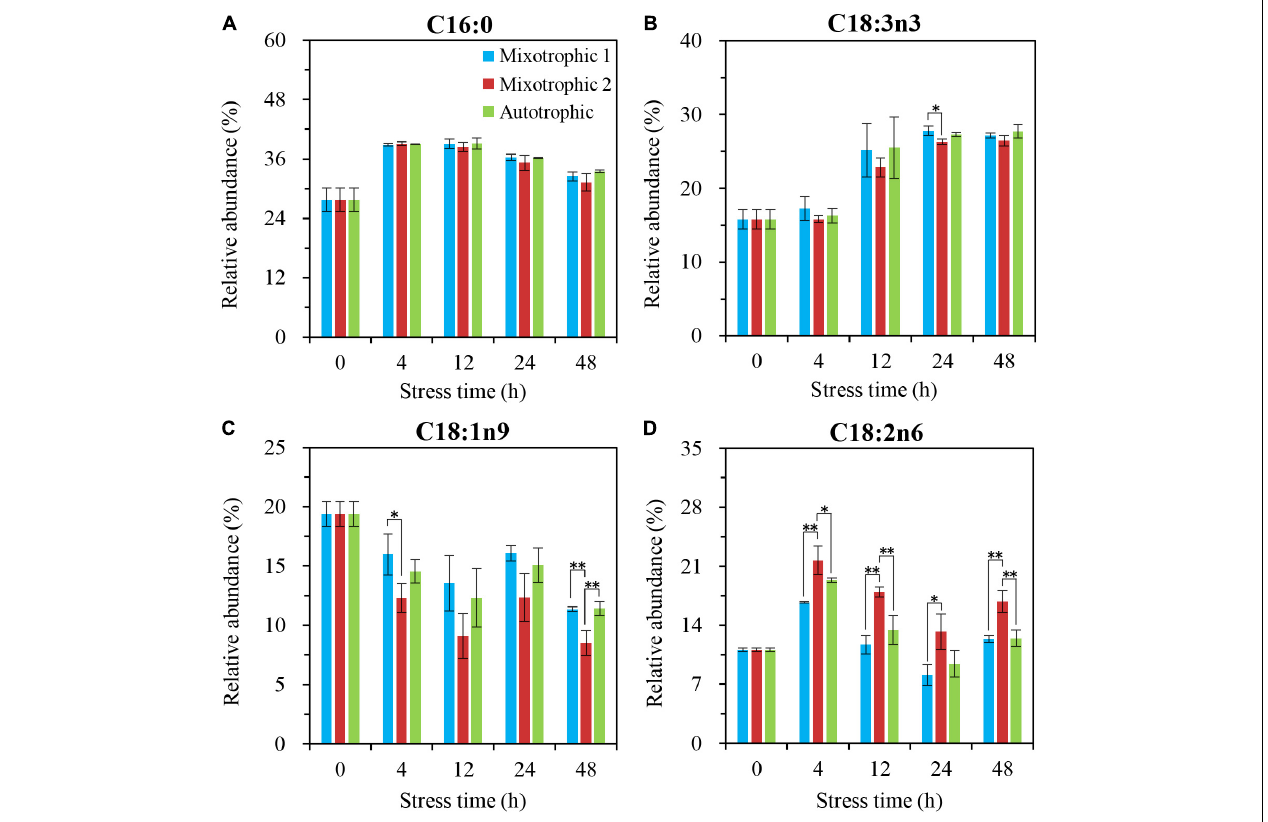
FIGURE 9 | Time course of changes in the relative abundances of the major fatty acyls in DGDG of C. reinhardtii BAFJ5 under three carbon supply regimes over 48 h of HL-N. The carbon supply regimes for mixotrophic 1, mixotrophic 2, and autotrophic were 17 mM acetate and 2% CO 2 (v/v), 17 mM acetate and ambient 0.04% CO 2 (v/v), and 2% CO 2 (v/v), respectively. Cx:ynz, where x, y, and z refer to the number of carbon, the number of double bonds, and the position of the first double bond counting from the methyl end, respectively. Values are the means of three independent replicates ± SD ( n = 3). ∗ p < 0.05; ∗∗ p <